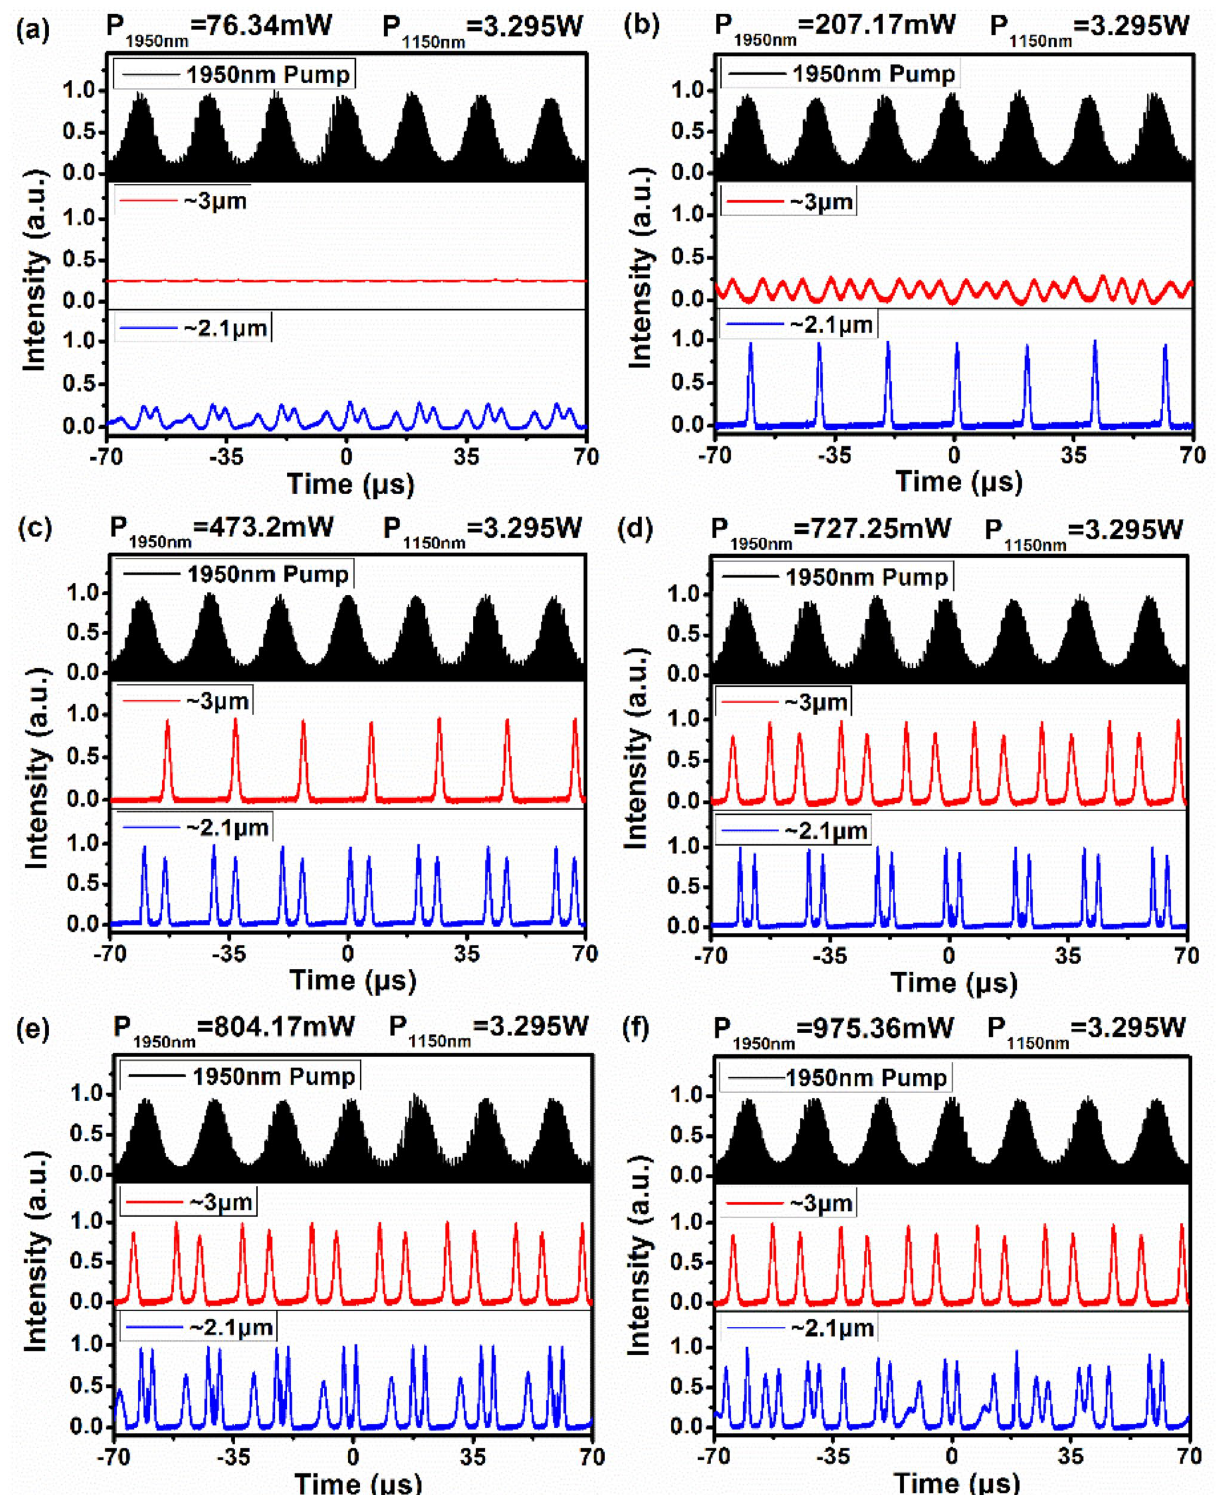
Figure 2. The temporal pulse evolution of dual-waveband gain-switching at the 1950 nm pump power of ( a ) 76.34 mW and ( b ) 207.17 mW; ( c ) 473.2 mW, ( d ) 727.25 mW, ( e ) 804.17 mW, ( f ) 975.36 mW with the 1150 nm pump power fixed at 3.295